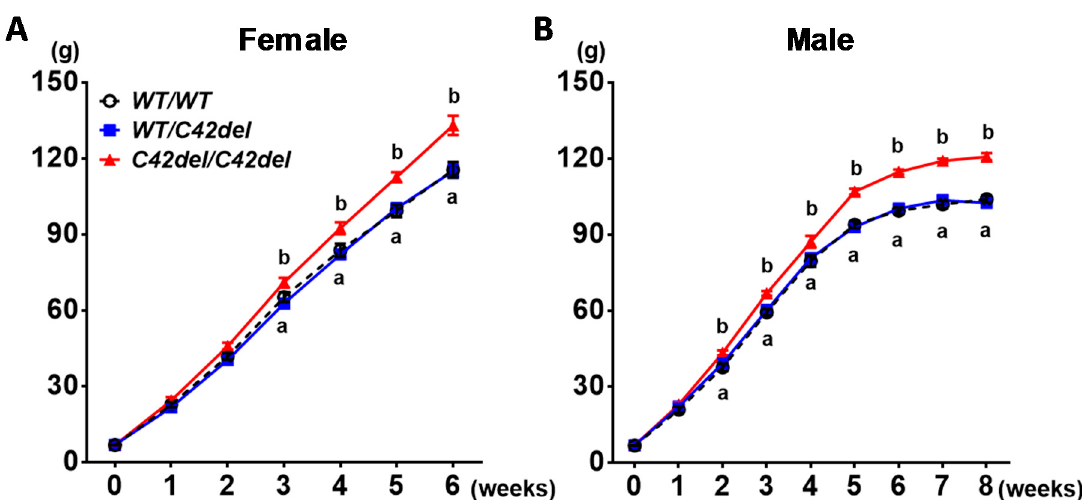
Figure 2. Comparison of body weights among groups in female ( A ) and male ( B ) quail. Body weights